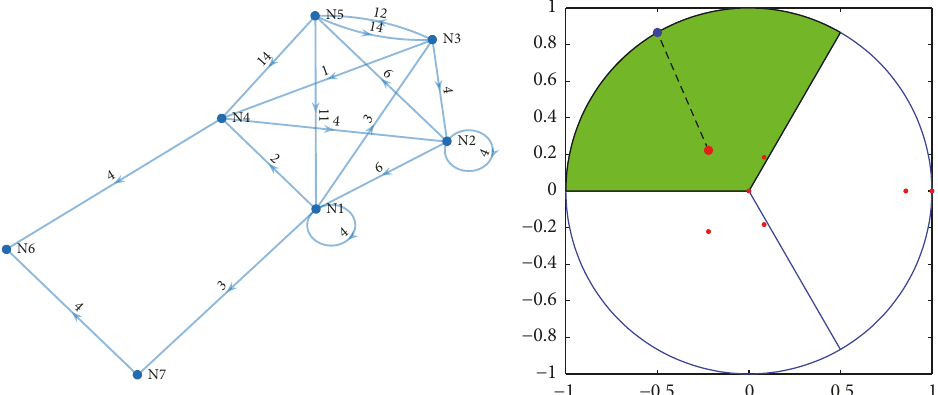
Figure 6: An example graph (left); eigenvalues of the recurrence matrix (right). The blue dot is the eigenvalue of the pure cycle of size 3. The big red dot is the generating eigenvalue as it is closest to the blue point within the green